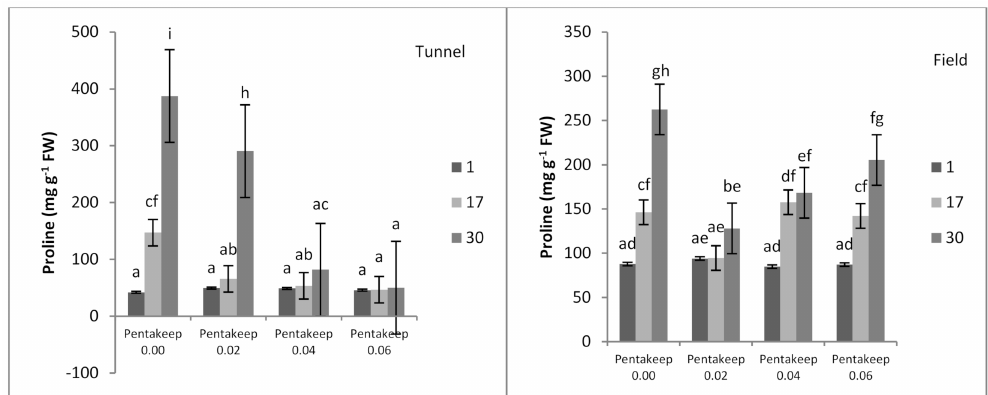
Figure 4. E ff ect of growth conditions (unheated foil tunnel and open field) and foliar treatment (six times during vegetative period) with di ff erent concentrations of Pentakeep V (0.00%, 0.02%, 0.04%, 0.06%) on the leaf proline content measured after 1, 17, and 30 days of storage of the P. multiflorum cut foliage in water. Values are mean ± SE, n = 5. The bars marked with the same letters are not significantly di ff erent at p < 0.05.